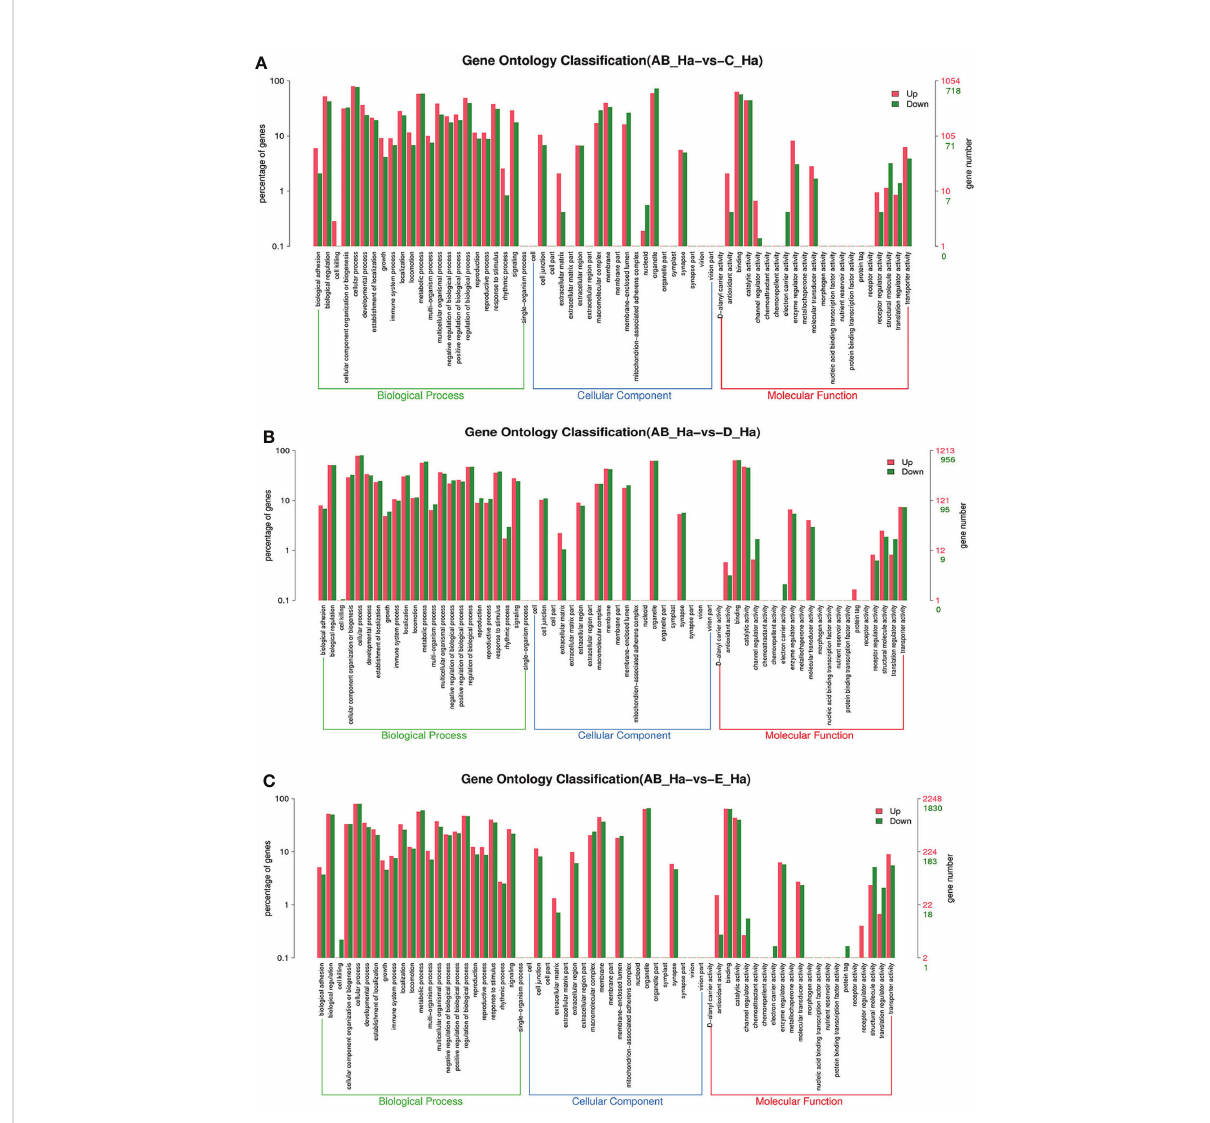
FIGURE 3 GO enrichment analyses of differentially expressed genes (DEGs) in hemolymph transcriptome. Notes: (A) Comparison between AB-Ha and C- Ha; (B) comparison between AB-Ha and D-Ha. (C) Comparison between AB-Ha and E-Ha. Notes (1): AB-Ha: hemolymph from post-molt; C- Ha: hemolymph from inter-molt; D-Ha: hemolymph from per-molt; E-Ha: hemolymph from ecdysis (2). Red columns indicate GO item entries enriched by upregulated differentially expressed genes; green columns indicate GO item entries enriched by downregulated differentially expressed genes. (3) The x -axis shows the item name between two stages, whereas the y -axis represents the number of genes and their percentage of the corresponding